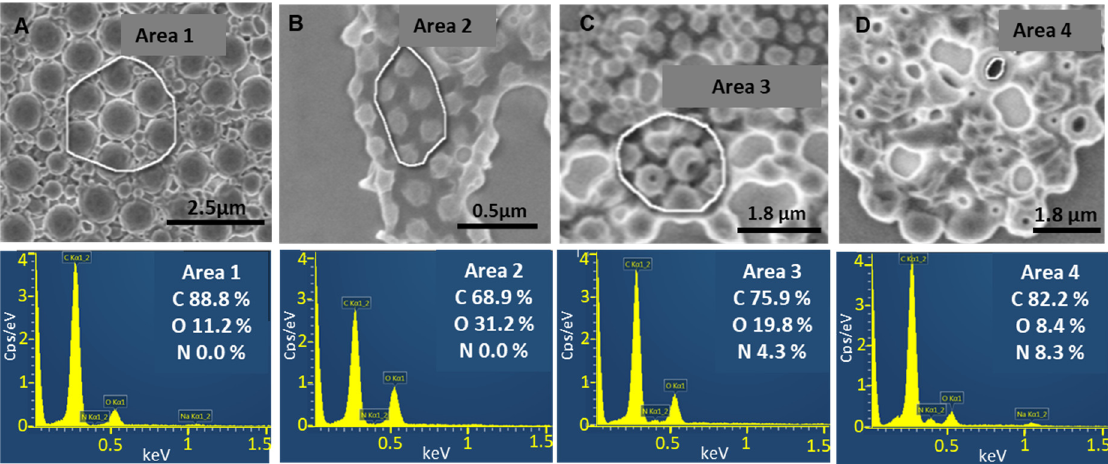
Figure 7. SEM images (top) with EDX analysis (below) of ( A ) empty PLGA 15 C NPs, ( B ) VCM-loaded PLGA 15 C NPs. Sample B was continuously analyzed until holes appeared due to polymer melting ( C,D ) and EDX analysis was further focused on the inner regions which were thus revealed.